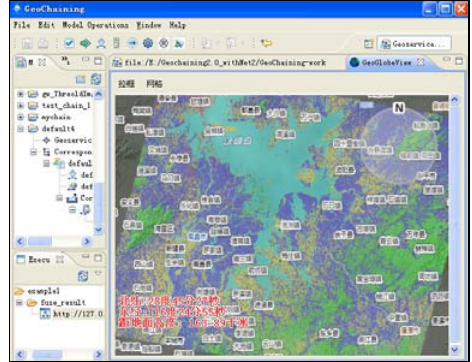
Figure 5. Data results